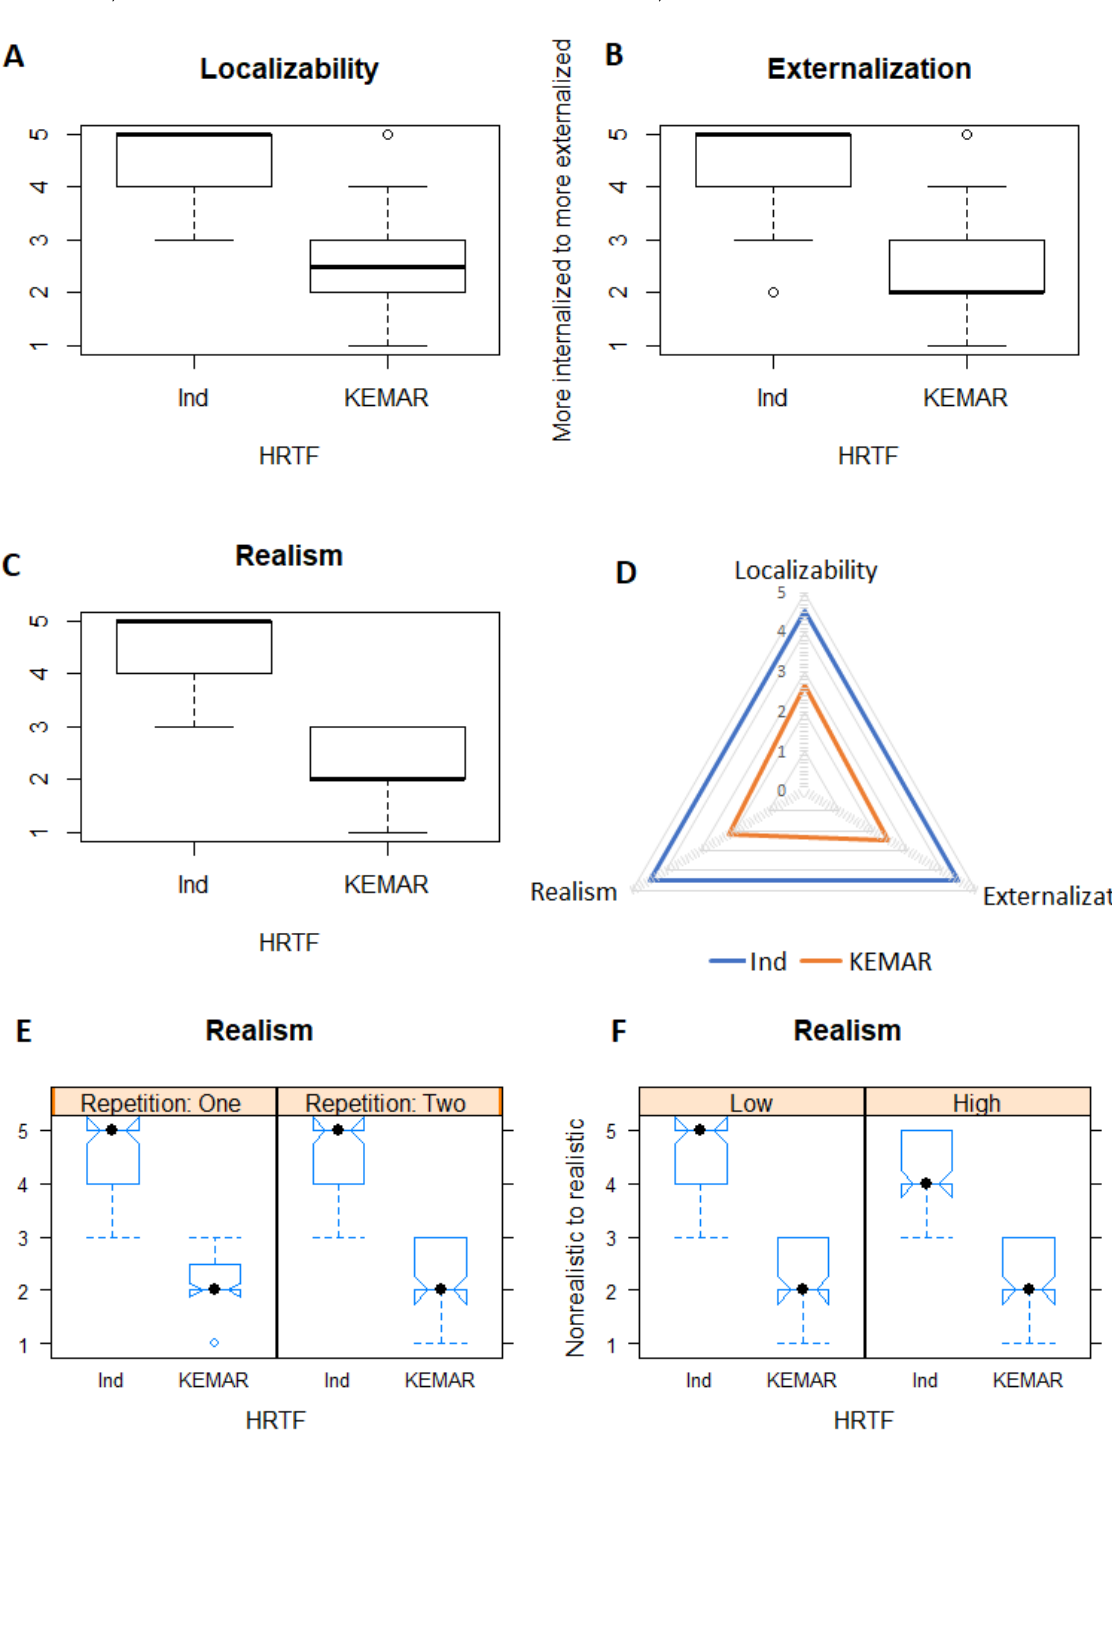
Figure 4. Result of the first test (individual vs KEMAR). A: Localizability overall box plot; B: Externalization overall box plot; C: Realism overall box plot; D: Radar chart for localizability, externalization, and realism; E: Realism repetition response behavior; F: Realism expertise response behavior. Ind: individual HRTF; KEMAR: Knowles Electronics Manikin for Acoustic Research; HRTF: head-related transfer